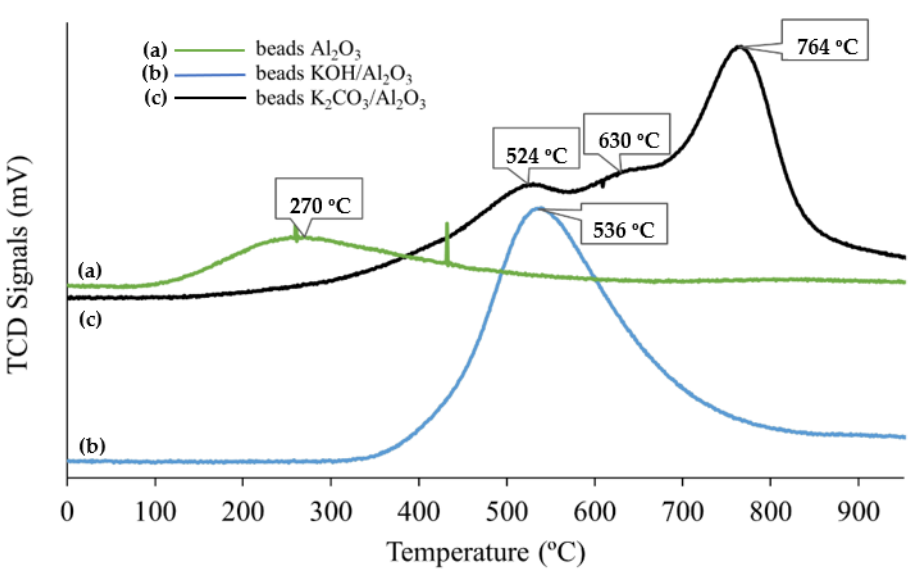
Figure 5. TPD-CO 2 profile of calcined material for beads Al 2 O 3 , beads KOH/Al 2 O 3 , and beads K 2 CO 3 /Al 2 O 3 .